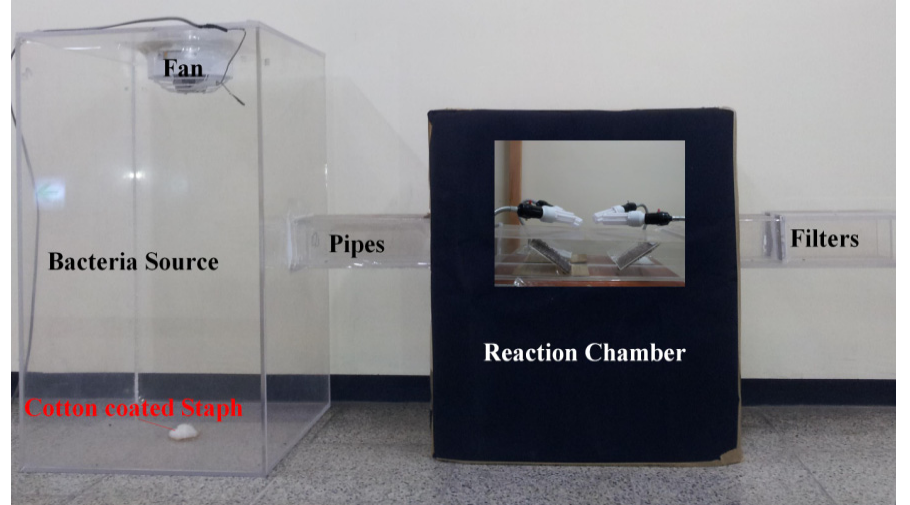
Figure 1. Schematic model of the bacterial photocatalytic disinfection